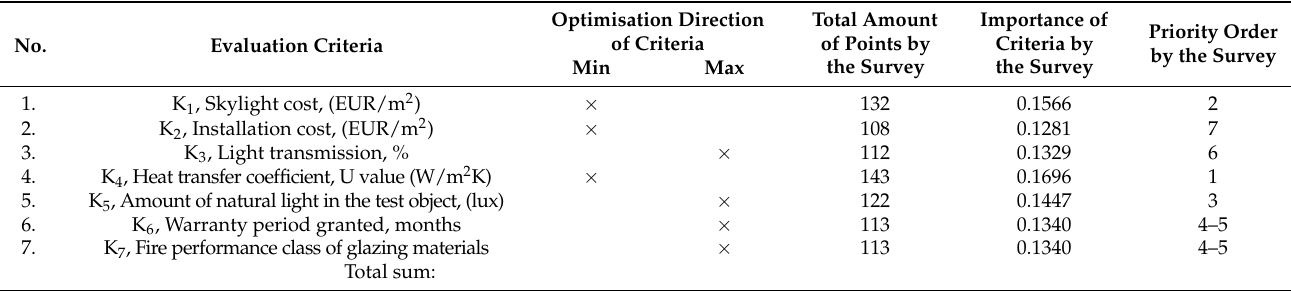
Table 18. Priority order of criteria by